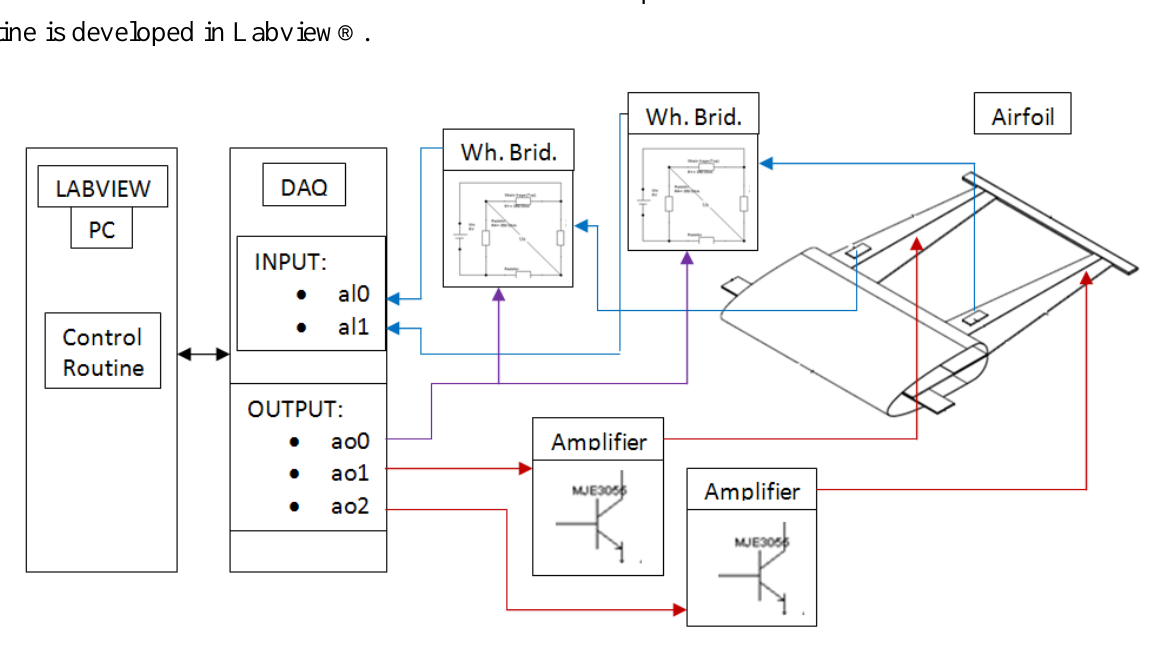
Figure 8. Position feedback system